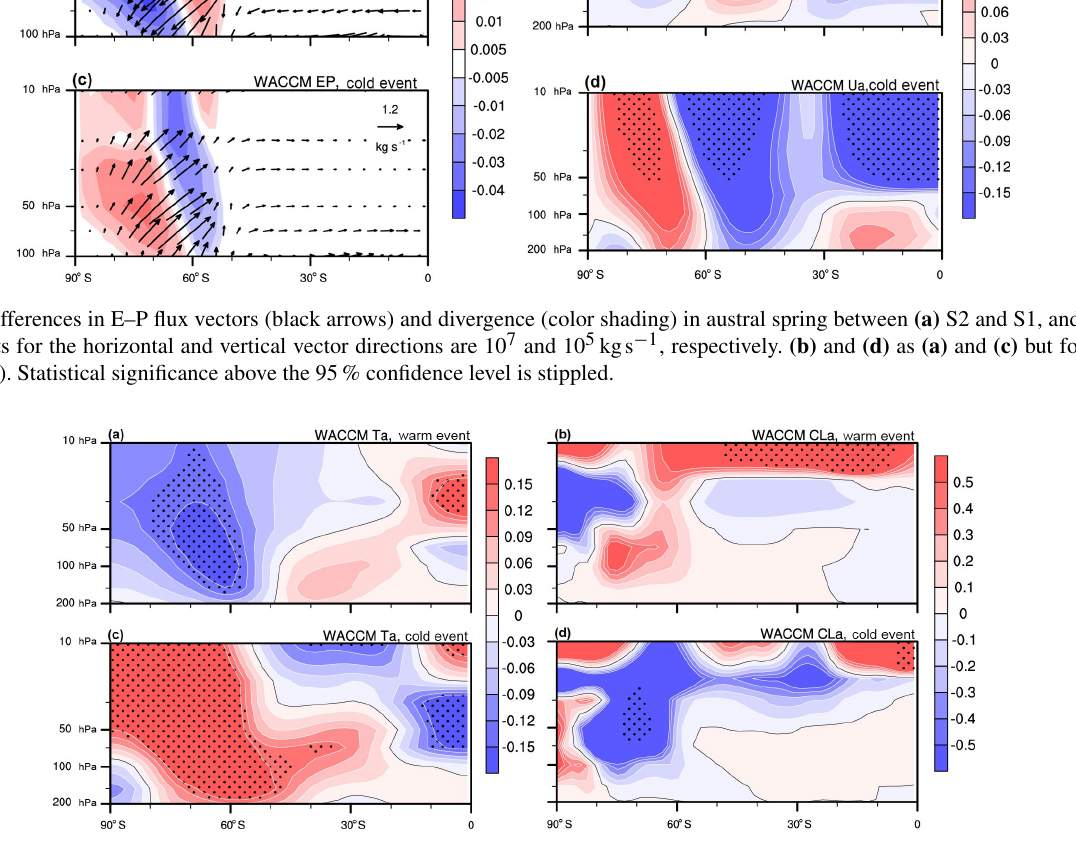
Figure 10. Zonal mean difference in temperature (K) in austral spring between (a) S2 and S1, and (c) S3 and S1. (b) and (d) as (a) and (c) but for active chlorine (ppbv). Statistical significance above the 95% confidence level is